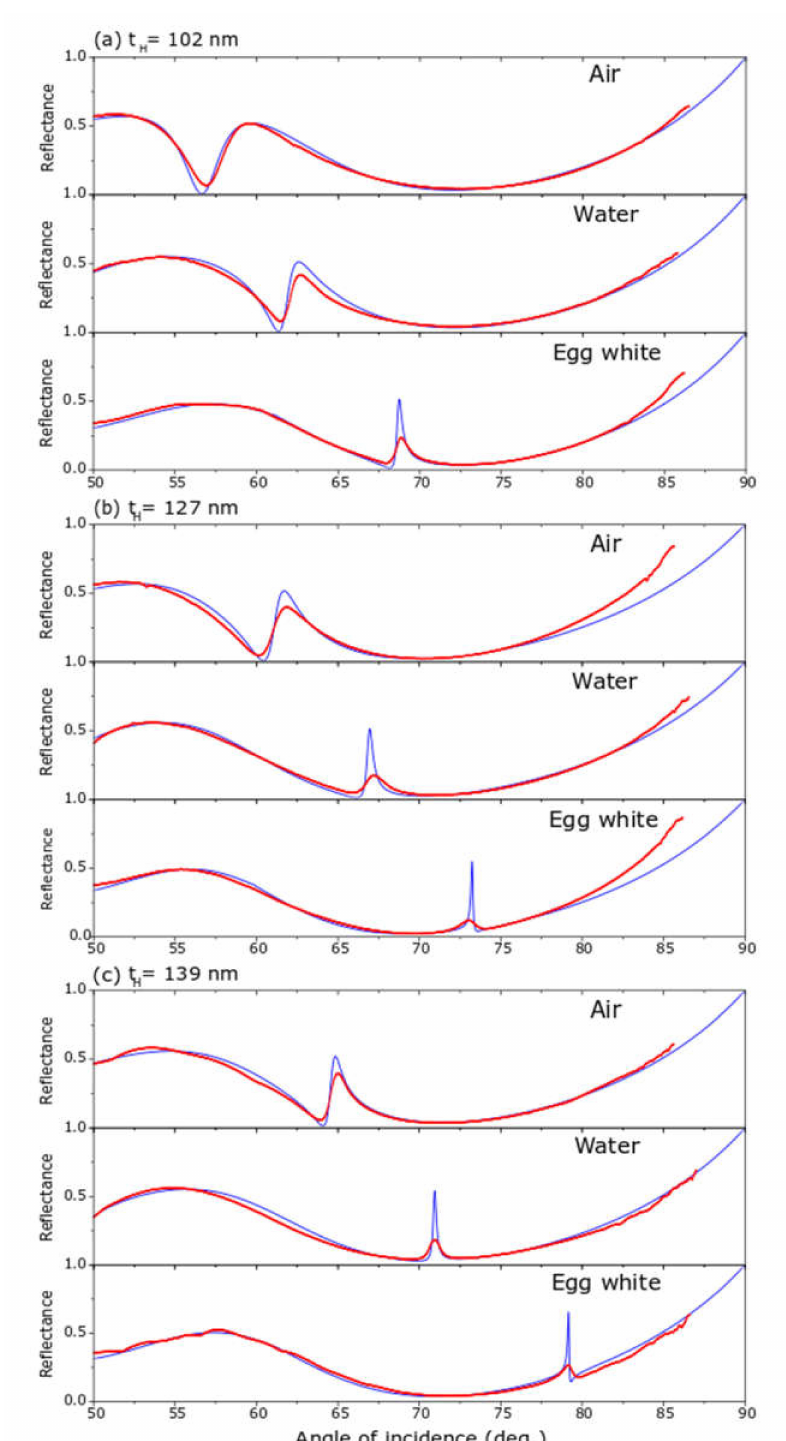
Figure 6. ATR spectra of three multilayer sensors for three sensing media: air, water and dried egg white. Sensors are identified by the thickness of the H-layer: ( a ) 102 nm, ( b ) 127 nm and ( c ) 139 nm. Red curves represent experimental data and the blue are the respective